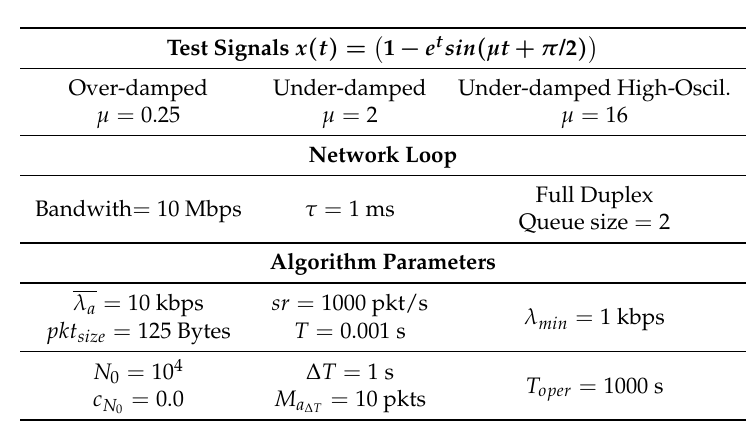
Table 1. Simulation